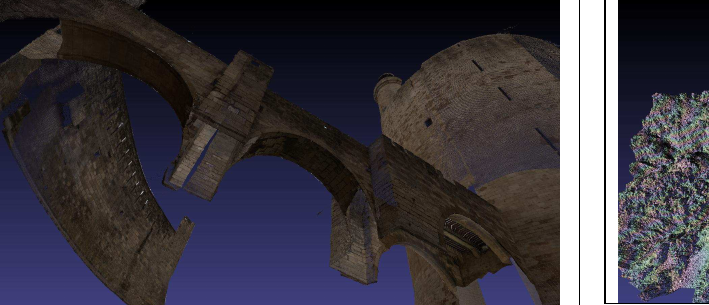
Figure 2. .Modelization of the brige of tour de constance, Aiguemortes.